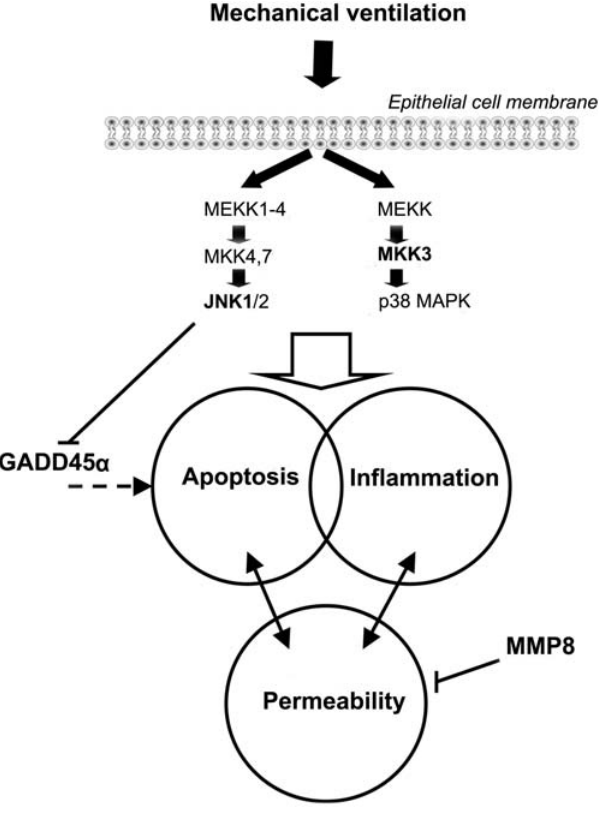
Figure 12. Theoretical interactions of MAPK, GADD45 a and MMP8 in alveolar epithelial cells. The p38 and JNK MAPKs transmit injury signals from the cell surface to the nucleus resulting in inflammation and apoptosis. Alveolar-capillary permeability interacts with inflammatory and apoptotic pathways. JNK1 MAPK inhibits GADD45 a expression, which effects apoptotic signaling. MMP8 protects against increased alveolo-capillary permeability. Dashed line=theore- tical connection. Arrow=activation, bar=inhibition